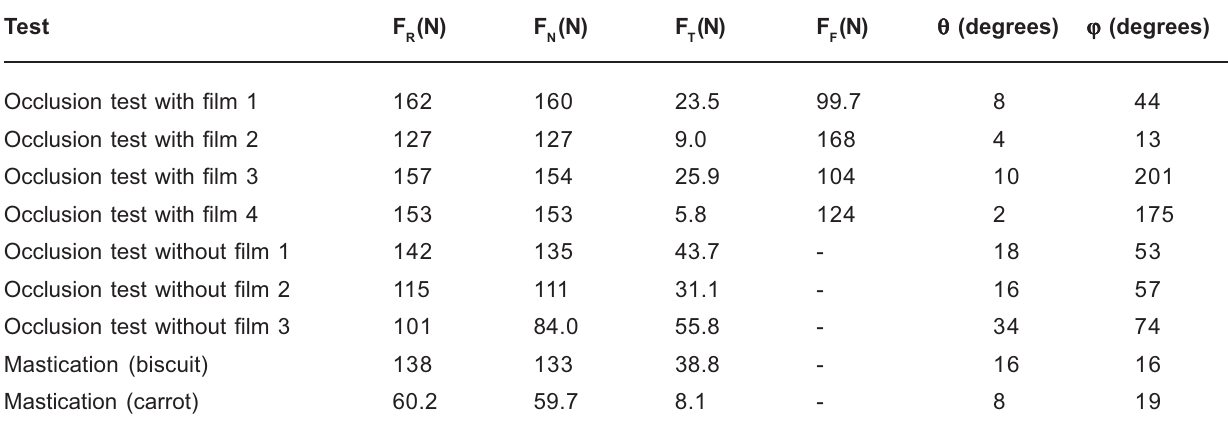
* F - maximum resultant forces; F R film. Angles θ and ϕ are shown on Figures 1 and 2,